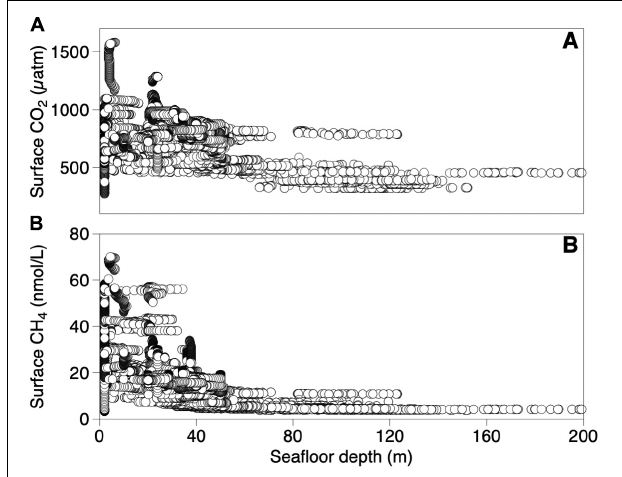
FIGURE 5 | (A) pCO 2 ( µ atm) and (B) CH 4 concentration (nmol/L) in the surface waters vs. seafloor depth along the cross section from Askö to Tvärminne.